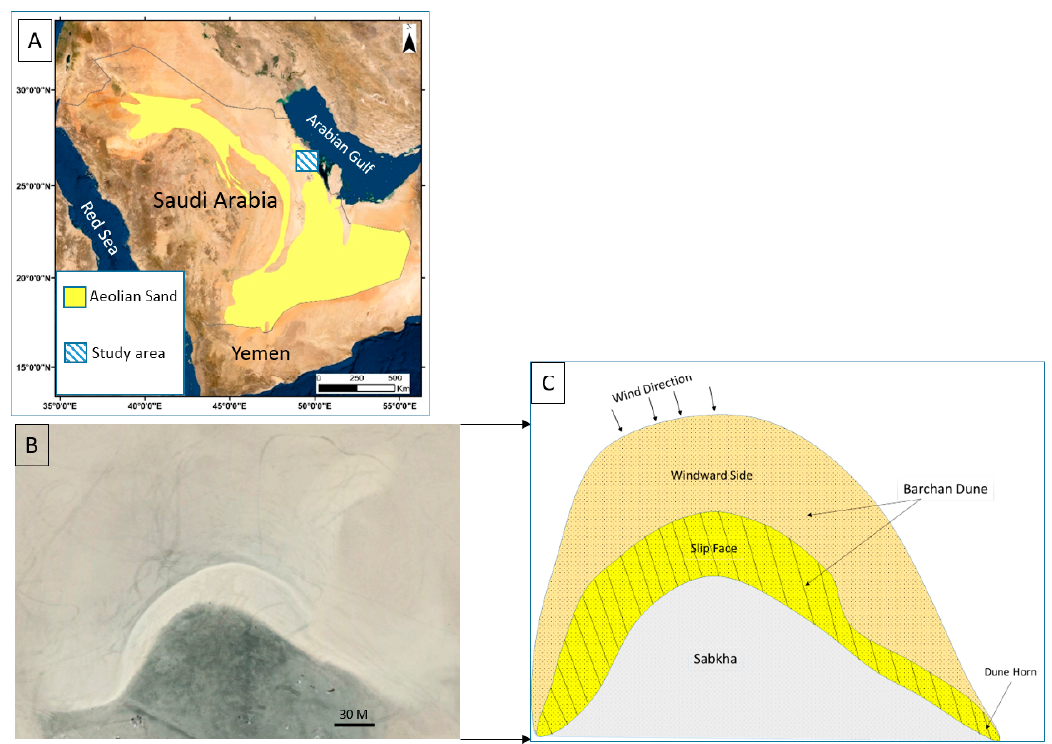
Figure 1. ( A ) A satellite image showing the distribution of aeolian sand in Saudi Arabia, ( B ) a high-resolution satellite image of the studied Barchan dune in the Eastern Province of Saudi Arabia, and ( C ) a schematic illustration of the studied Barchan sand dune.